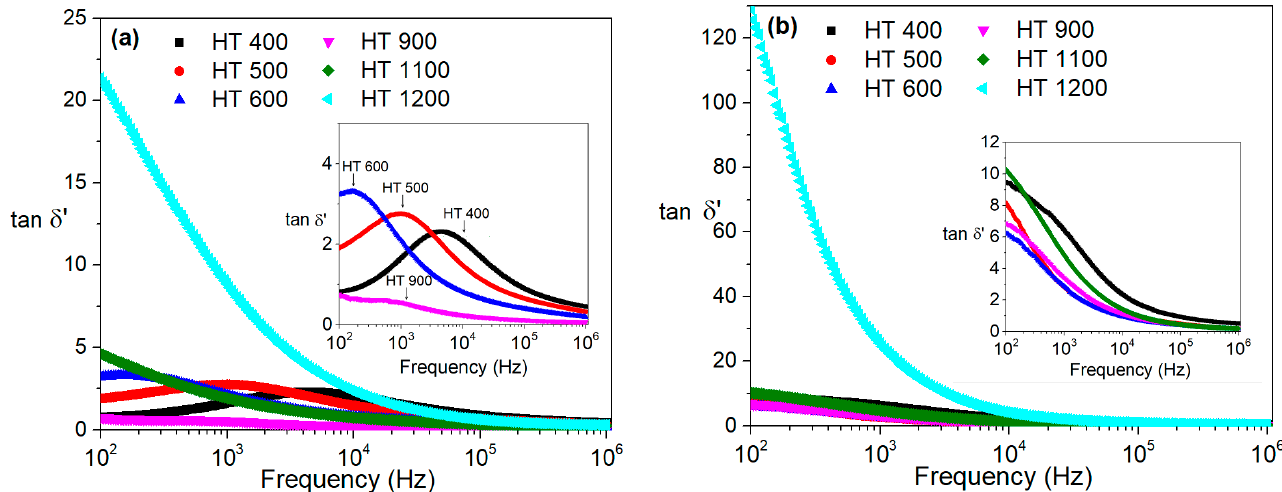
Figure 12. Loss tangent at room temperature for the samples prepared via the ( a ) colloidal gel and ( b ) polymeric gel methods.